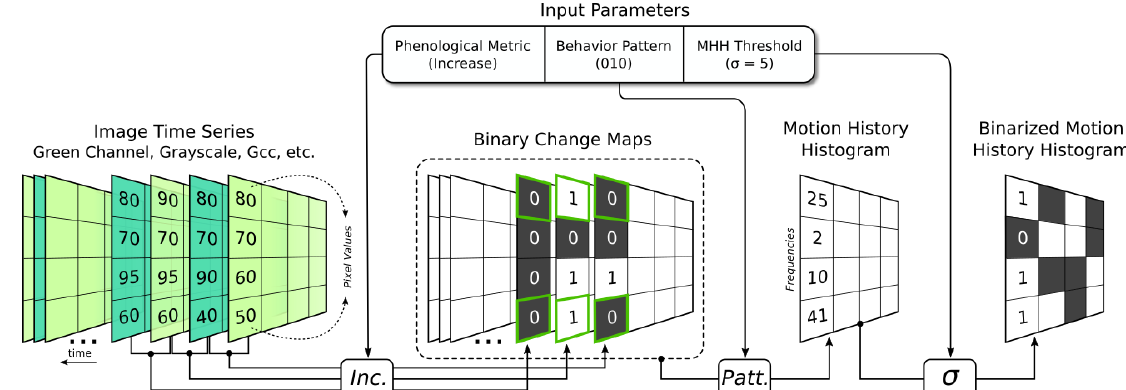
Figure 3. Pipeline of the Binarized MHH generation. This example illustrates the entire process applied to detect a specific pattern throughout the image series. First, two consecutive images I i and I i + 1 from an image series S = { I i , I i + 1 ,..., I n : 0 ≤ i ≤ n , n ≥ 1 } are compared according to a phenological metric (in this example, the pixel Increase). The comparison yields a binary change map CM i spotting out the pixels that conform to the metric. As comparisons proceed (i.e., as i increases) all change maps (CMs) are inspected towards detecting pixels that change according to a behavior pattern (in this example, 010 ). Finally, the MHH is gradually updated upon detections. Suppose a pixel at position ( x 1 , y 1 ) is found to follow the desired pattern (in this example, green border cells) at a certain point of the examinations. In such a case, MHH ( x 1 , y 1 ) would increase by one. After the entire time series has been processed, the MHH is binarized by means of a predefined threshold sigma ( σ